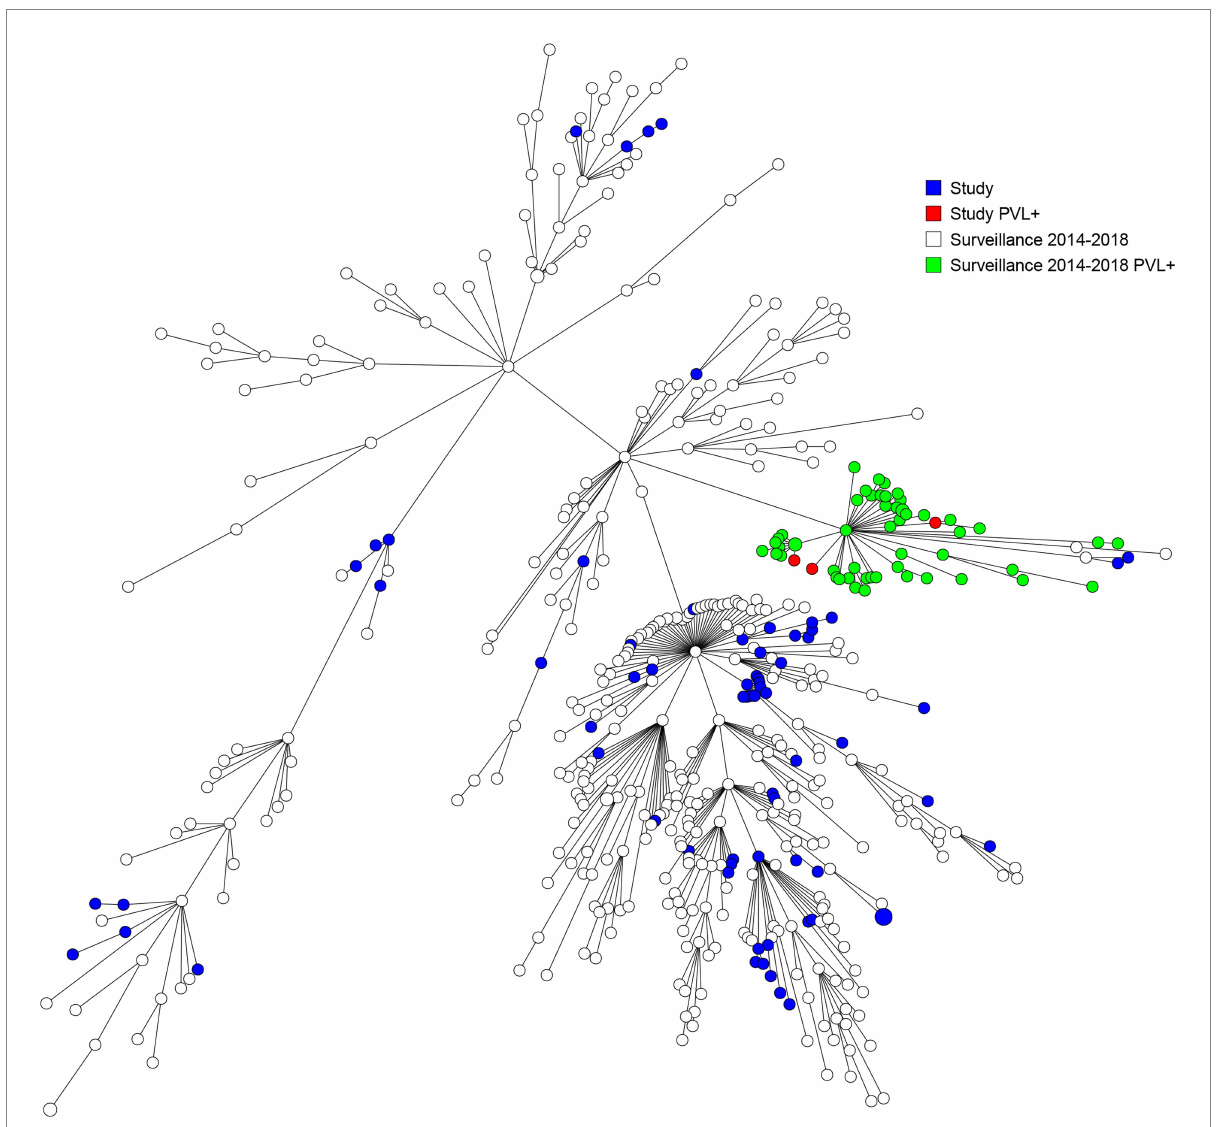
FIGURE 3 Minimum spanning tree based on wgMLST including both study and national surveillance isolates from 2014 till